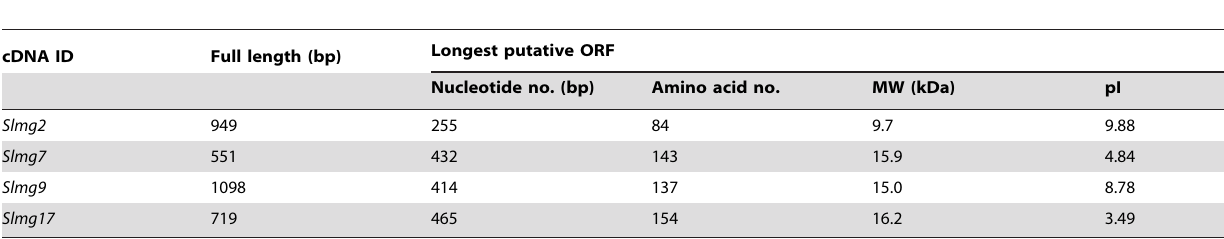
Table 4. Open reading frame analysis of the four larval midgut-predominant genes in Spodoptera litura .